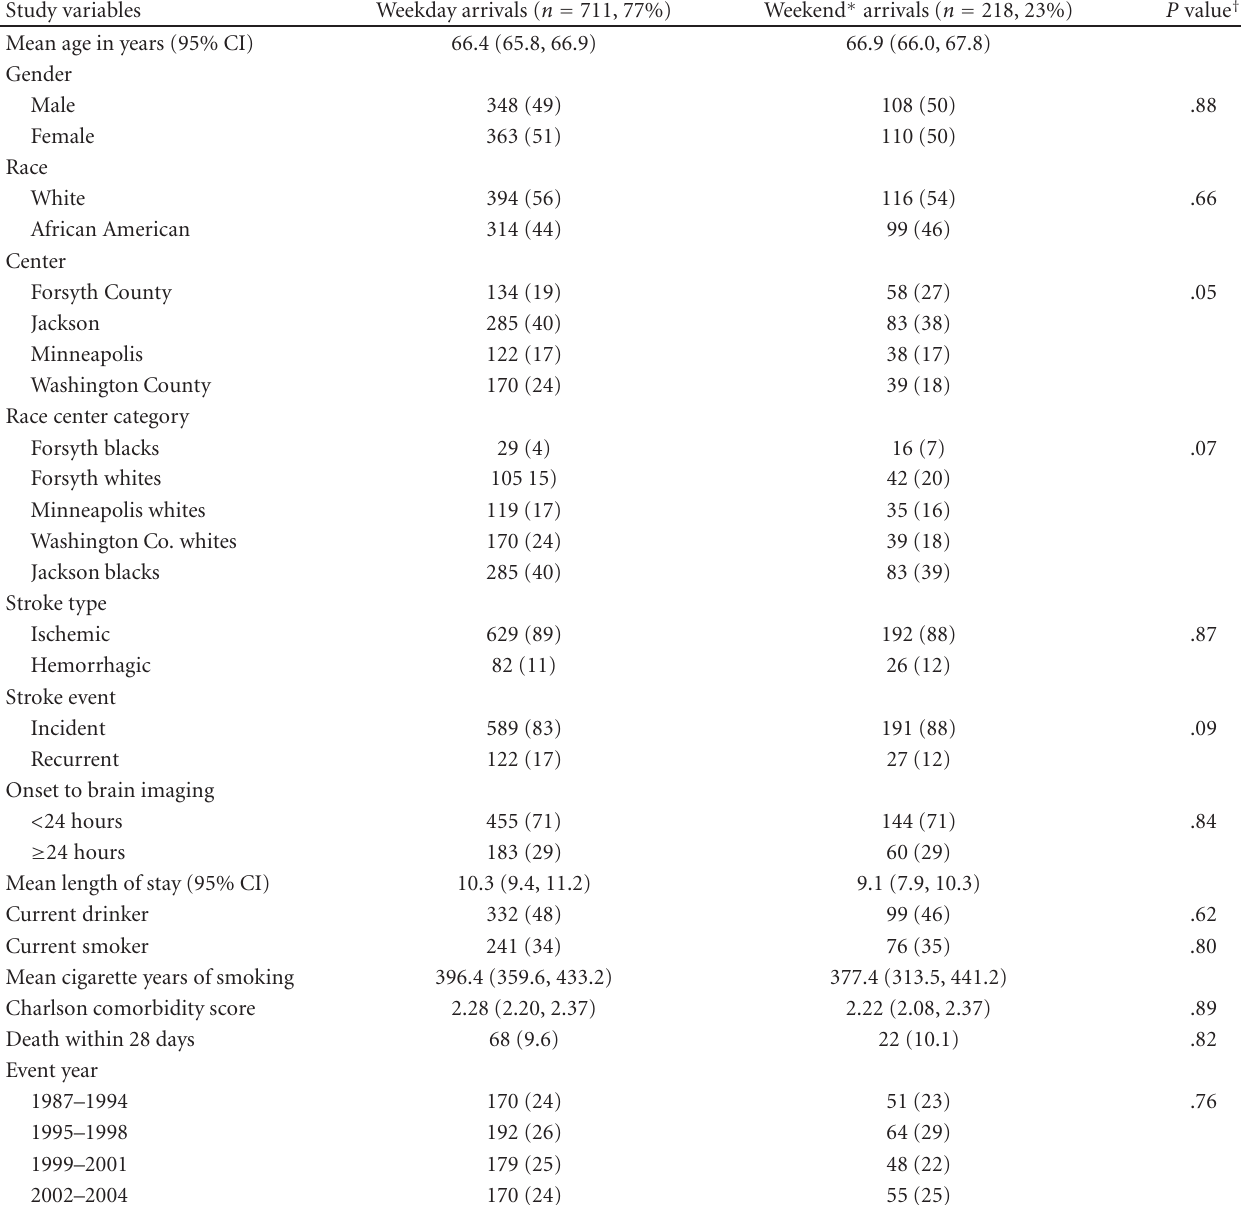
Table 1: Baseline characteristics (1987–1989) of stroke patients by day of hospital arrival in the atherosclerosis risk in communities (ARIC)